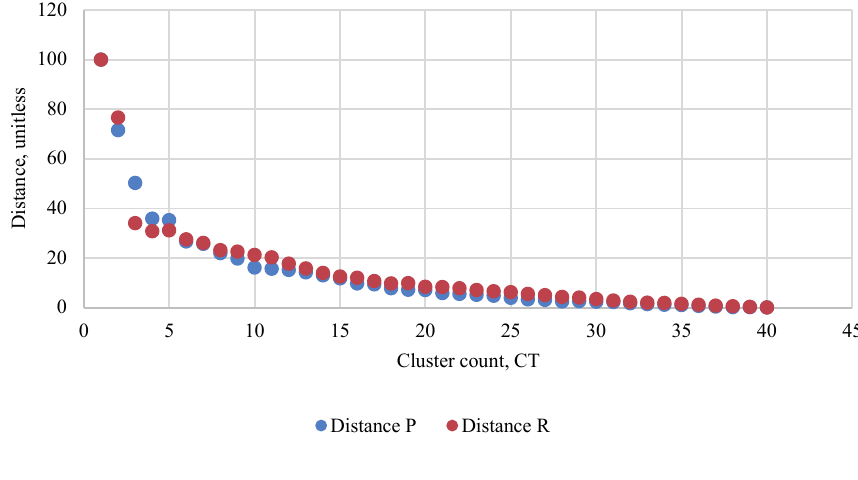
Fig. 2. Normalized Clustering results